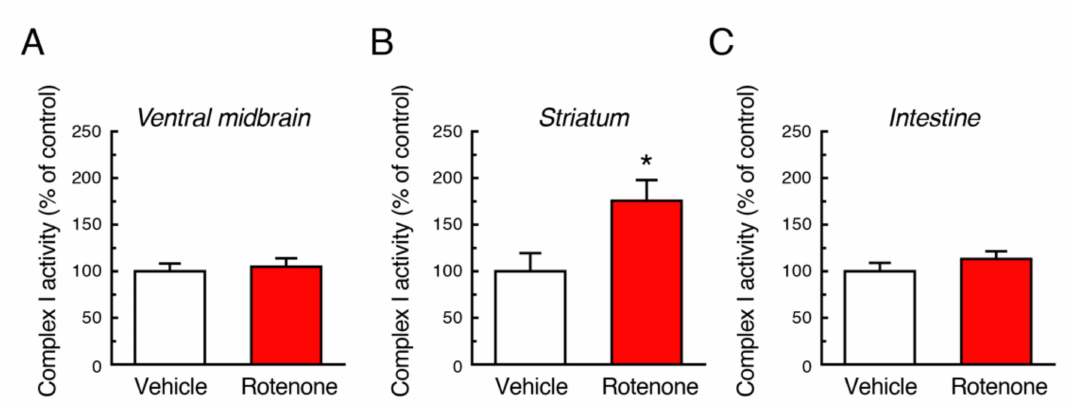
Figure 10. Changes in mitochondrial complex I activity after chronic exposure to low-dose rotenone in mice. Complex I activity was measured in the ventral midbrain ( A ), striatum ( B ) and intestine ( C ) 4 weeks after rotenone treatment. Each value is the mean ± SEM (Vehicle: n = 4; Rotenone: n = 5). * p < 0.05 vs. the vehicle-treated control group (two-tailed unpaired independent